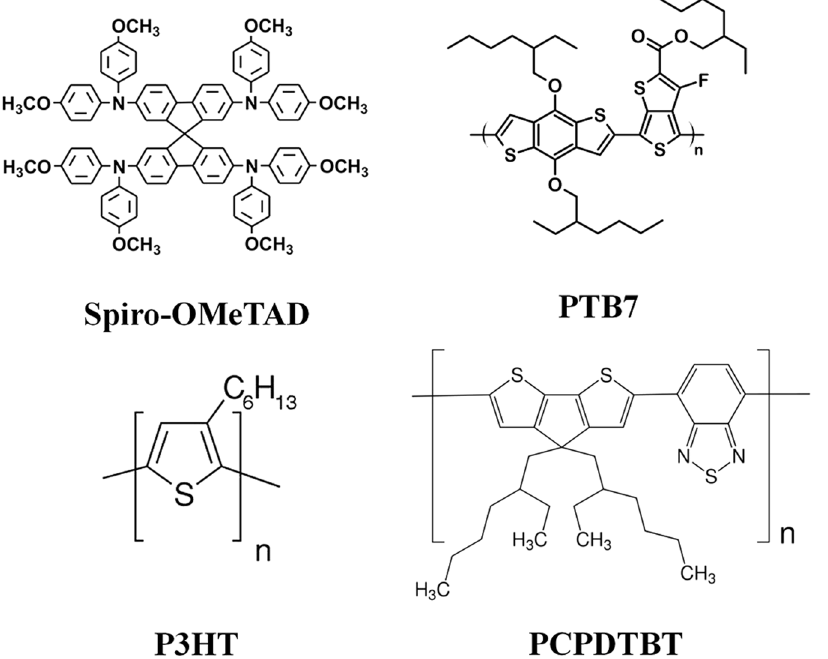
Figure 1. Molecular structure of the HTMs employed in this